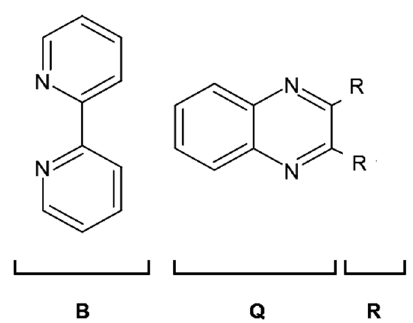
Figure 14. Decomposition of ppl-R ligands in terms of B (bipyridine), Q (quinoxaline) and R fragments.